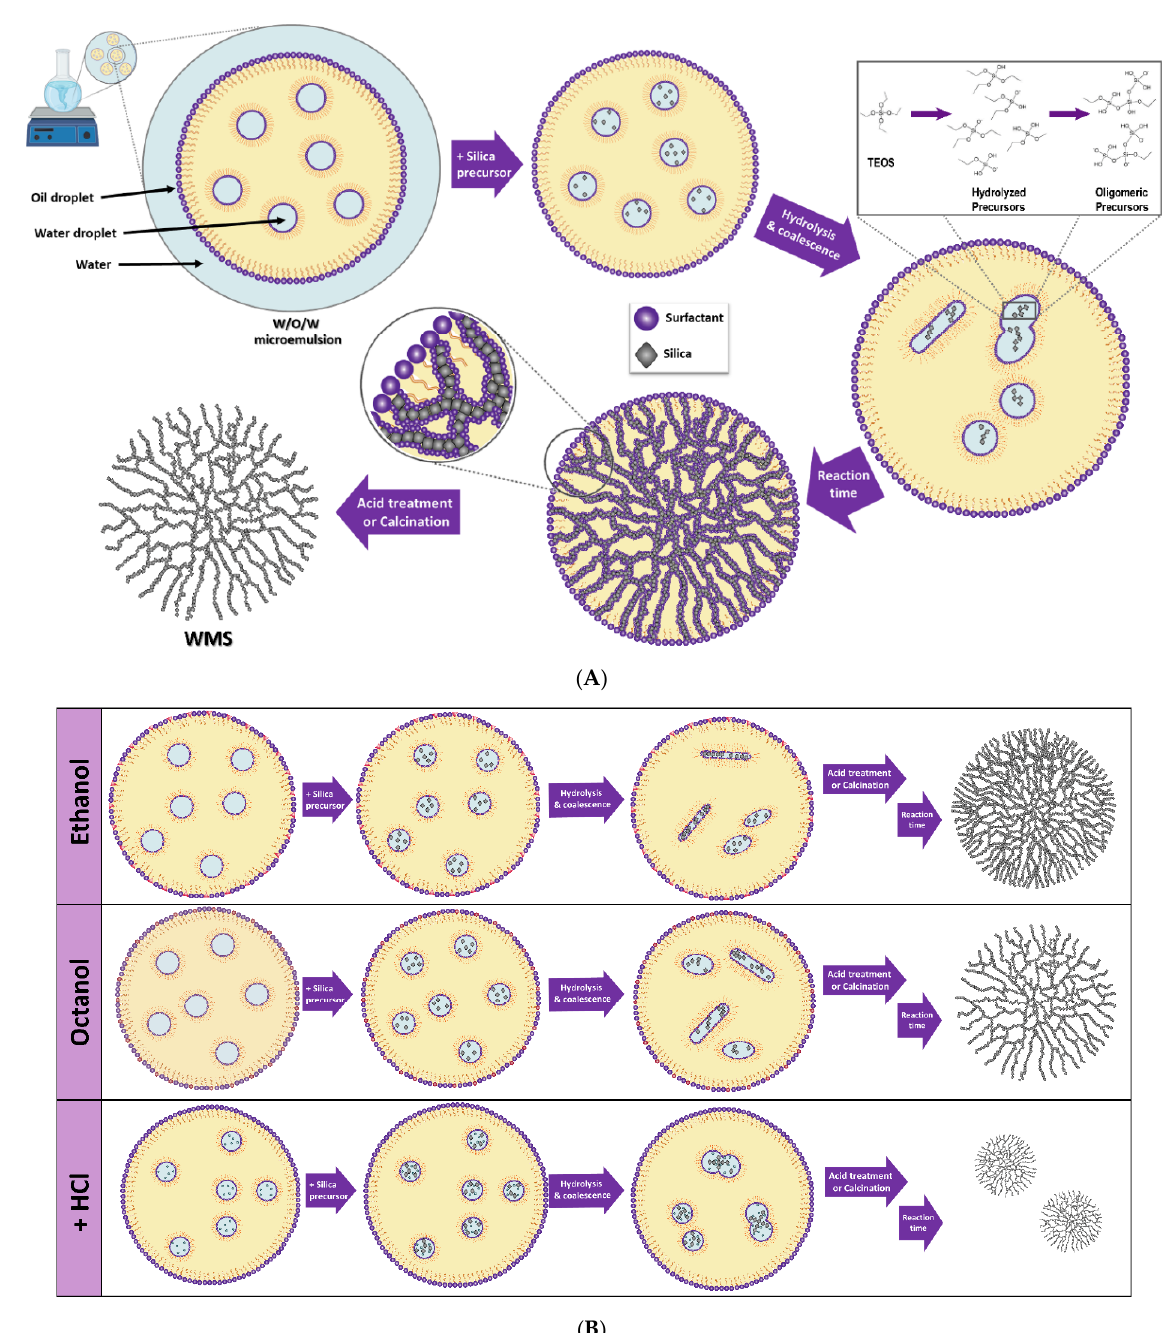
Figure 6. ( A ) Mechanism of formation of WMS in a bicontinuous (W/O/W) emulsion. ( B ) Effect of co-solvent and presence of HCl on micelle formation.